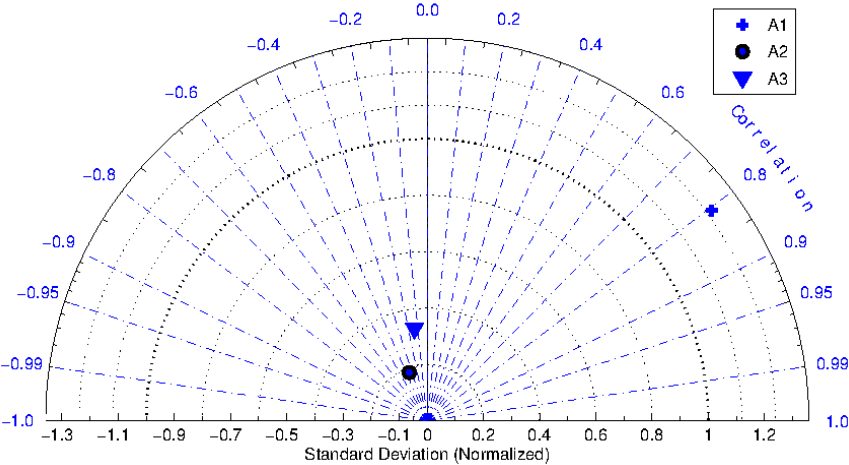
Figure 5. Taylor Diagram showing the three areas used for comparison with SOCAT observational data. A1 is the only area with statistically significant correlation.